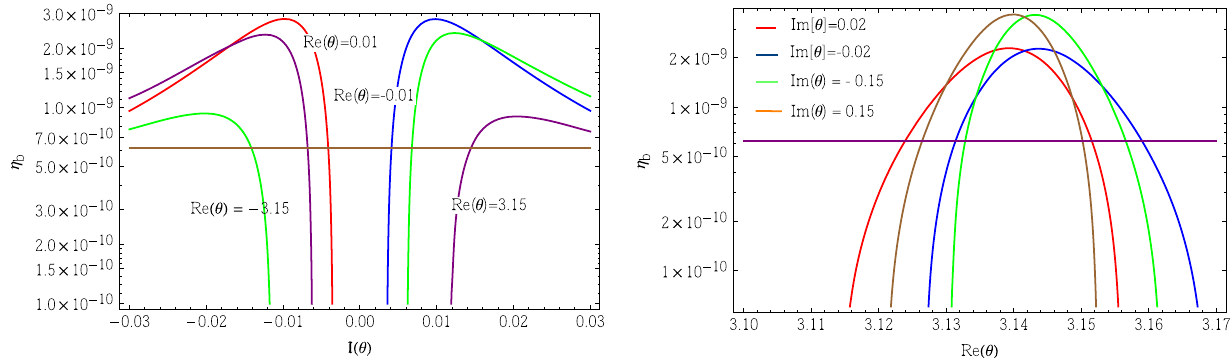
Fig. 8 Estimating the baryon asymmetry in the strong-washout regime. Left panel: Plot of the baryon asymmetry as a function of the (cid:11)[ θ ] . Right panel: Plot of the baryon asymmetry as a function of the (cid:15)[ θ ]